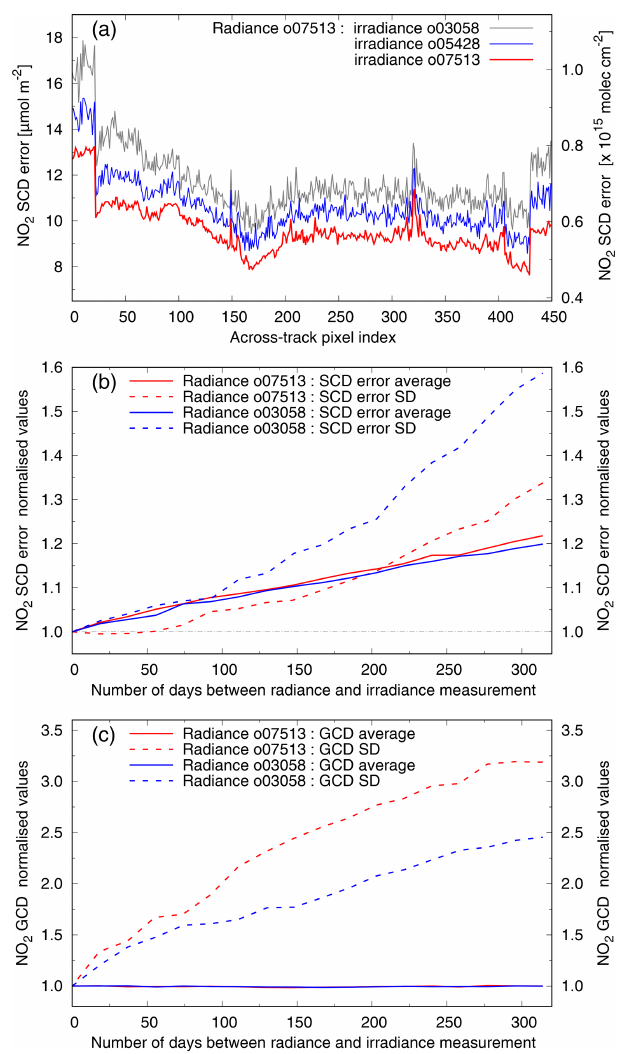
Figure 8. Effect of a difference between the radiance and irradi- ance orbit numbers on the NO 2 GCD and the SCD error, aver- aged over the TL range. (a) SCD error of radiance orbit 07513 (26 March 2019; red) using irradiance measurements from orbits 03058 (16 May 2018; blue), 05428 (30 October 2018; grey) and 07513. (b) SCD error averaged over detector rows 25–424 (solid) and the corresponding standard deviation (dashed) of two radiance orbits (red and blue colours) using a series of irradiance measure- ments, normalised to 1 for matching orbits, as function of the num- ber of days between radiance and irradiance measurement. (c) Idem for the GCD (solid) and corresponding standard deviation (dashed); note that the two solid GCD curves almost exactly overlap at nor- malisation value